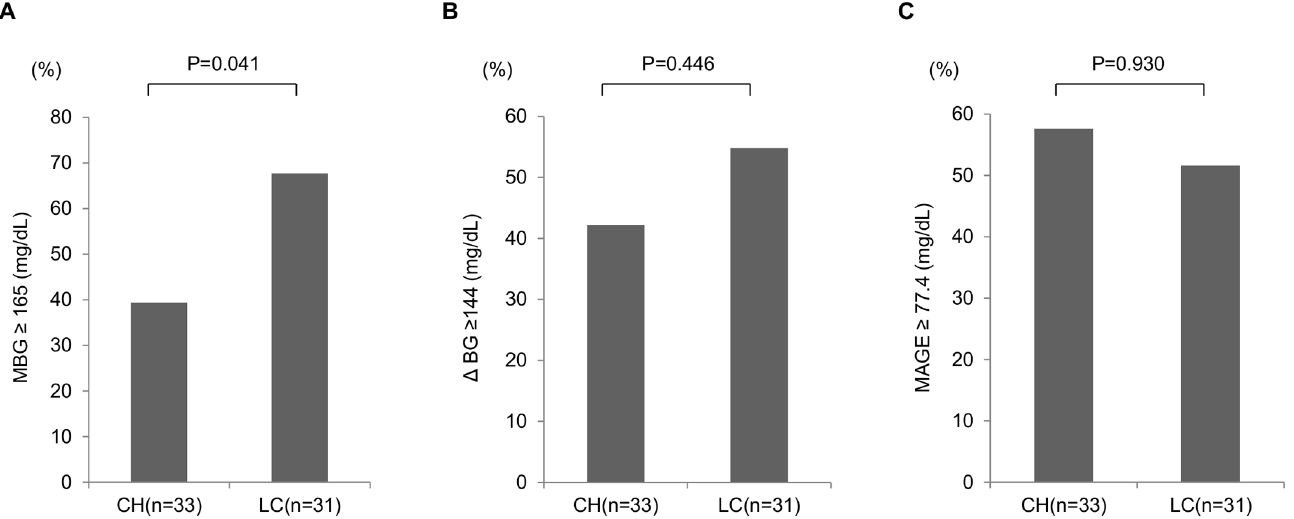
Fig 2. Comparison of CGM parameters between CH group and LC group among patients with HbA1c levels of (cid:21) 7.0%. (A) MBG, (B) Δ BG, and (C) MAGE. The population of patients whose values were more than or equal to the cutoff values were compared between CH patients and LC patients. MBG: mean blood glucose, Δ BG: the difference between the highest blood glucose and the lowest blood glucose, MAGE: mean amplitude of glycemic excursion, CH: chronic hepatitis, LC: liver cirrhosis.